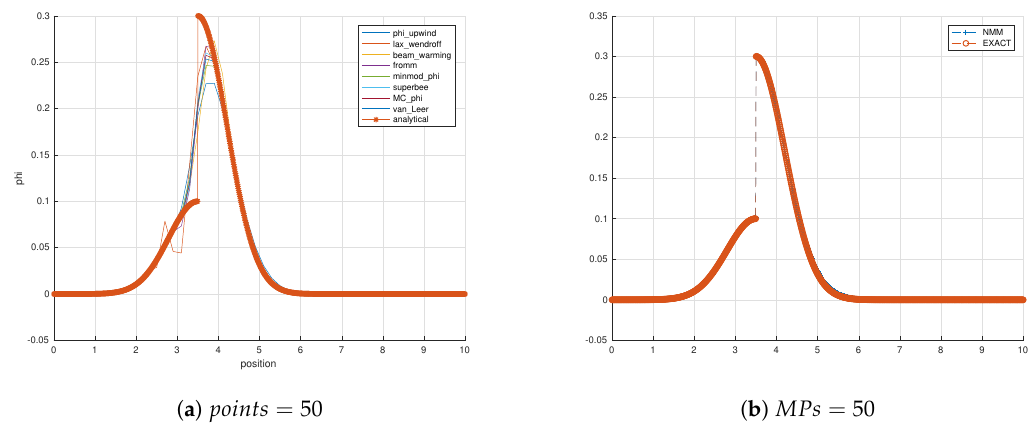
Figure 10. ( a ) The result of using the traditional finite volume method to solve the convection equation at time 0.5. ( b ) Using the method in this paper to solve the convection equation at time